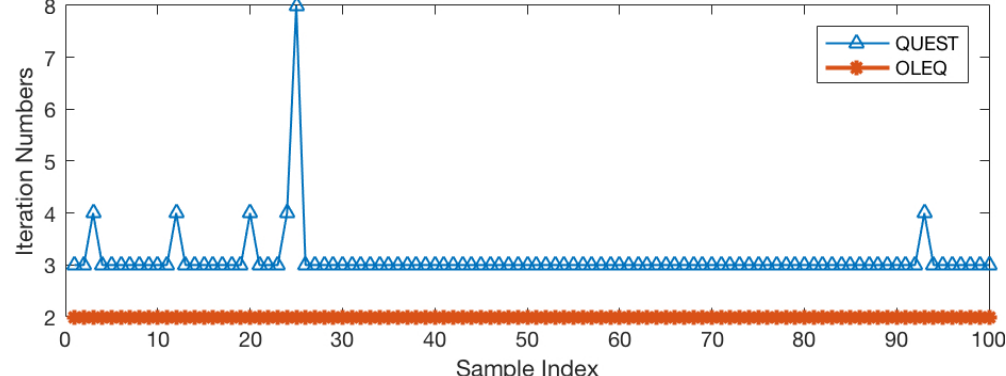
Figure 1. Iteration numbers of QUEST and OLEQ when faced with an extreme